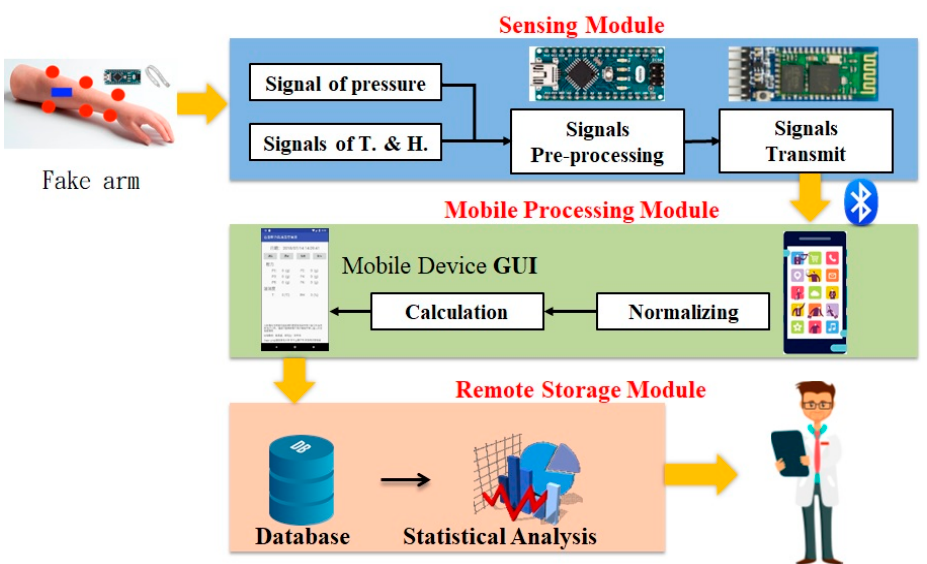
Figure 1. System architecture.